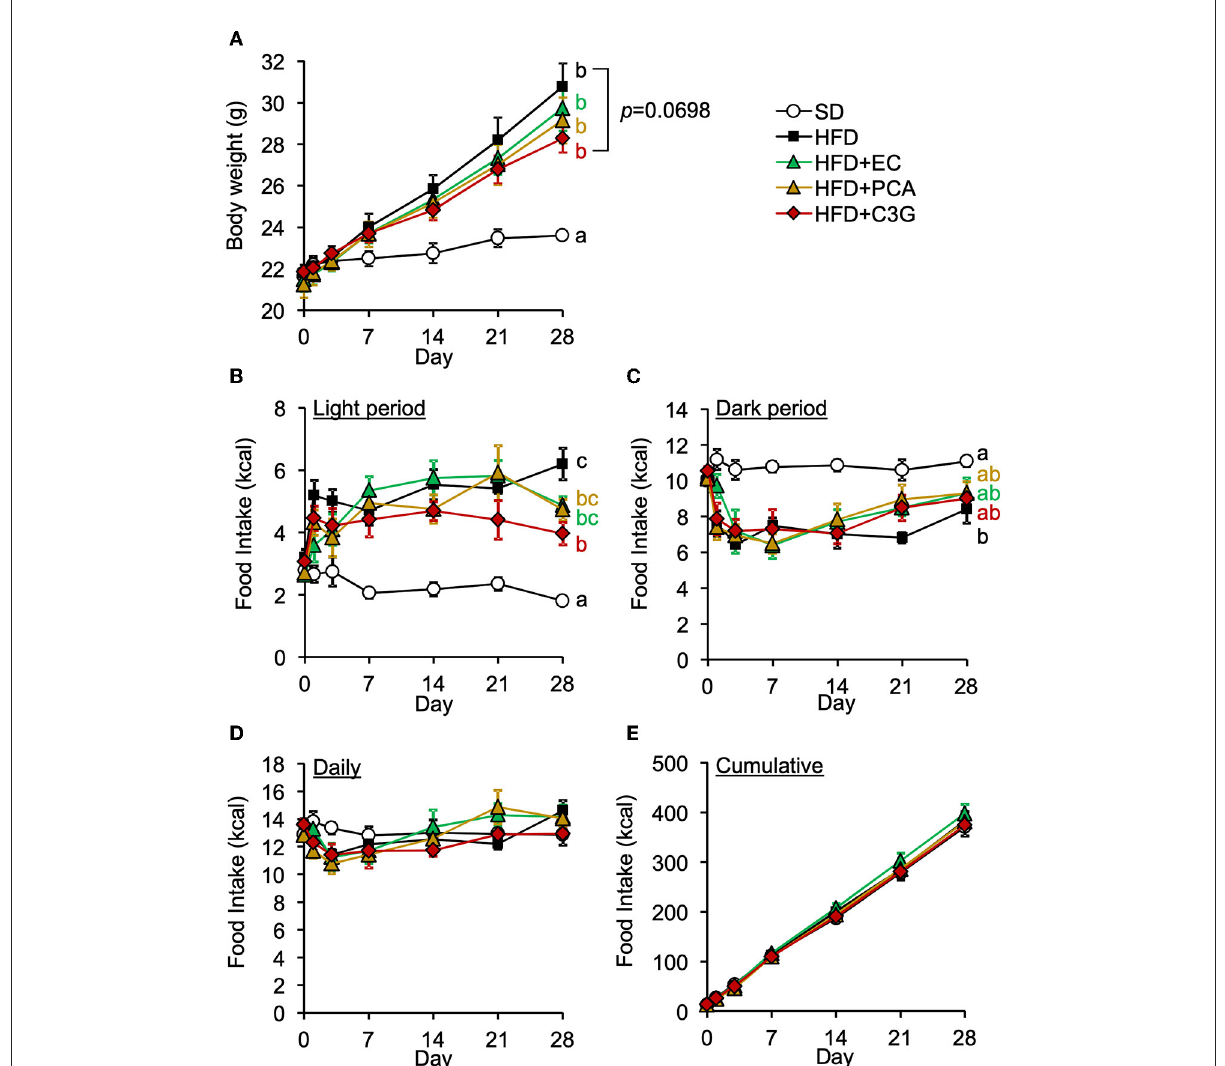
FIGURE7 Effects of three fractions derived from BE on the HFD-induced body weight gain and abnormal feeding pattern of mice. (A) Changes in body weight in each group during the 4-week study period. Food intake during (B) the light and (C) dark periods; and (D) daily and (E) cumulative food intake during the experimental period. Data shown are mean ± SE ( n = 6). Different letters represent significant differences among the five groups by each experimental period by Tukey-Kramer honestly significant difference test ( p < 0.05). The results of statistical analysis are shown only at the end points and the statistical data for the other time points are listed in Supplementary Table